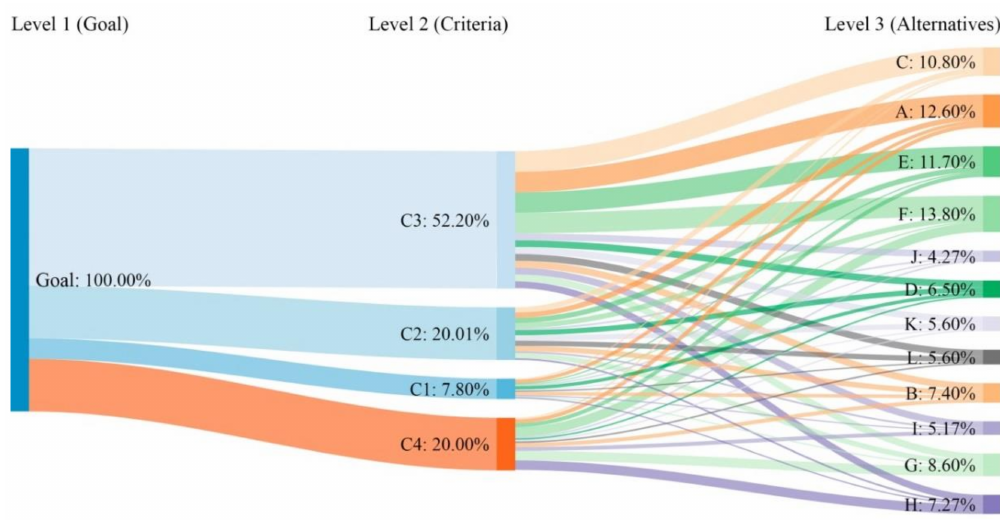
Figure 2. Priorities (%) of the elements of each hierarchical level. Notes: (1) The sum of criteria and alternatives = 100% in both cases. (2) The flow width from the criteria to the alternatives shows the weight of each criterion in each alternative. Source: Prepared by the authors (Sankey diagram).